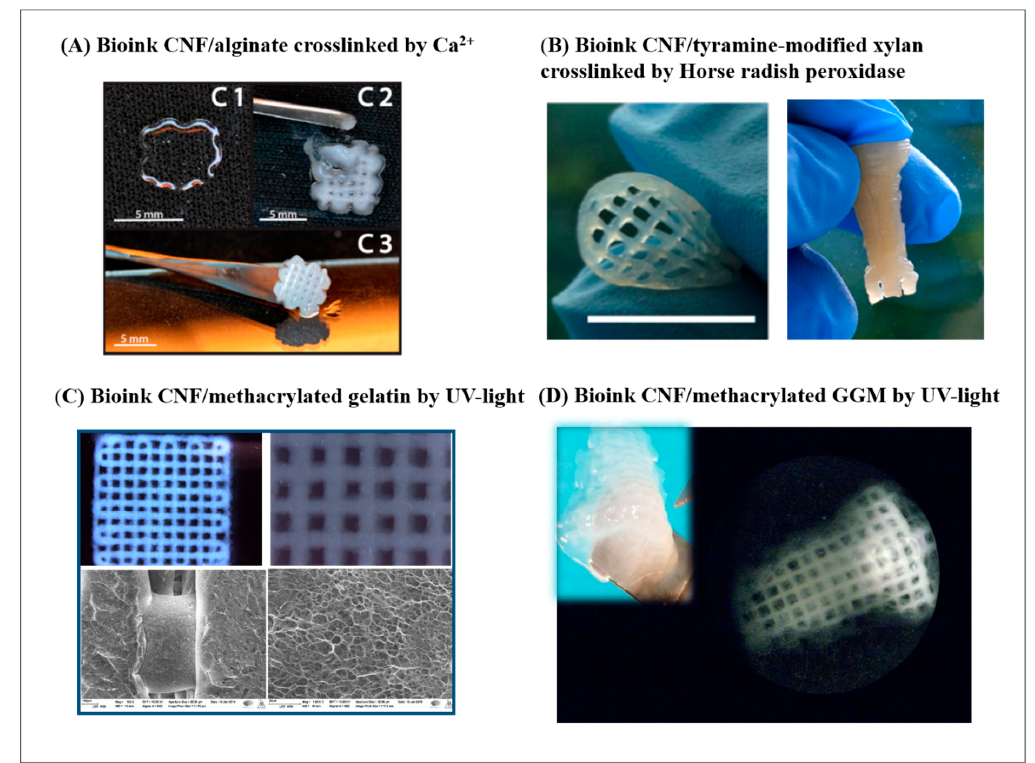
Figure 3. State-of-the-art CNF-based bioinks engaging different cross-linking strategies: ( A ) bioink CNF / alginate cross-linked by Ca 2 + , as presented in [45] (copyright permission from American